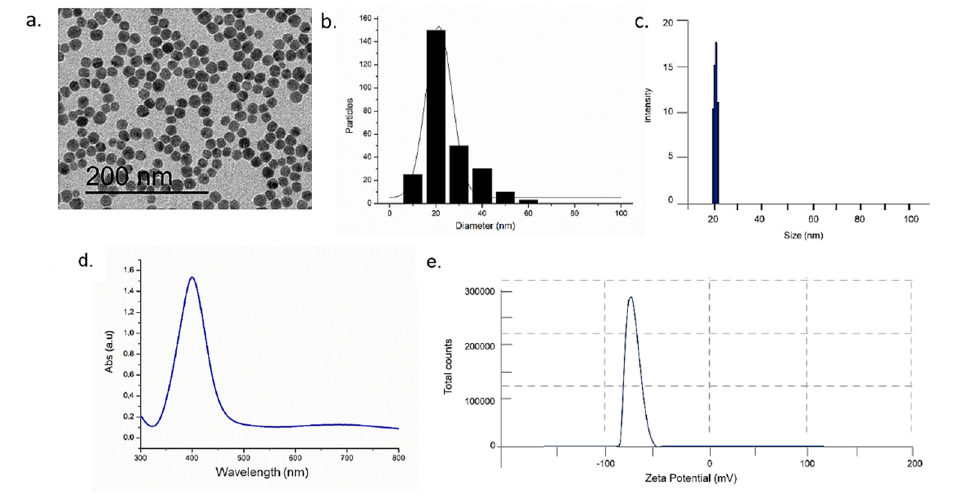
Figure 1. Characterizations of silver nanoparticles (AgNPs) in water: Representative TEM image ( a ), size distribution measured on 270 AgNPs and fitted with a normal function (solid line) ( b ), DLS ( c ), UV–vis ( d ) and ζ -potential measurement ( e ).